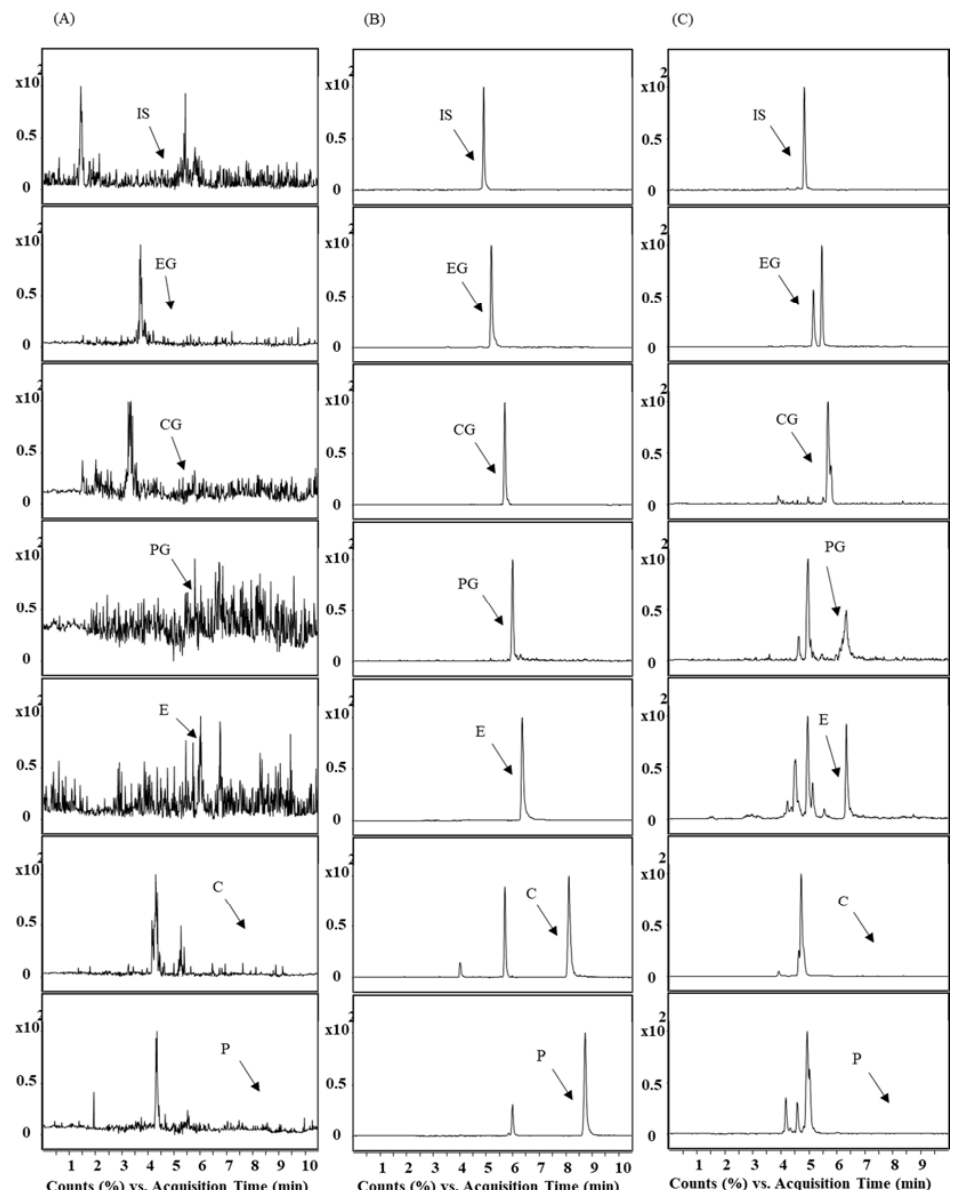
Figure 3. Representative MRM chromatograms of IS, EG, CG, PG, E, C, and P in rat plasma. ( A ) blank plasma; ( B ) blank plasma spiked with six anthraquinones (250 ng/mL for aglycones and 125 ng/mL for glycosides) and IS; ( C ) plasma sample obtained from rats 45 min after oral administration of R. acetosa extract (2 g/kg).